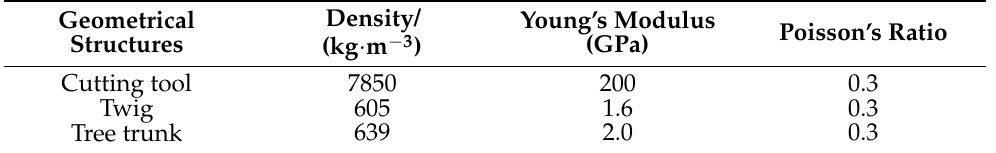
Table 1. Simulation of material properties.